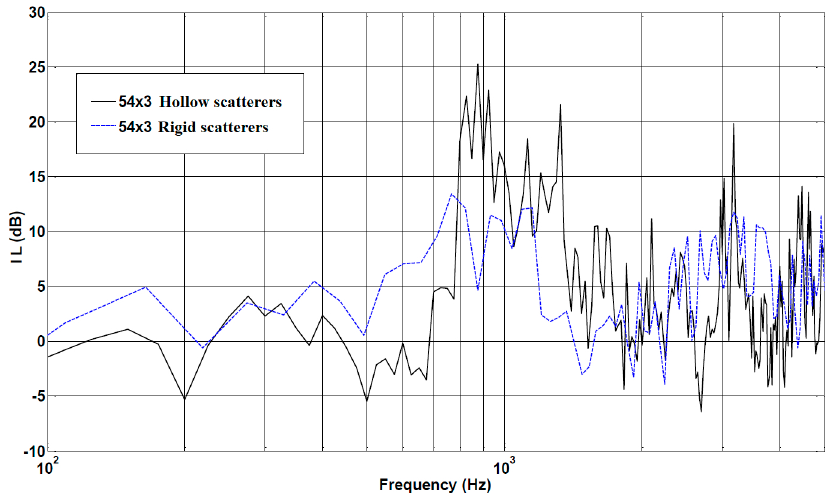
Figure 8. Insertion loss for a sonic crystal with 54 scatterers in three rows under hollow scatterer or solid scatterer conditions, modified from [39].